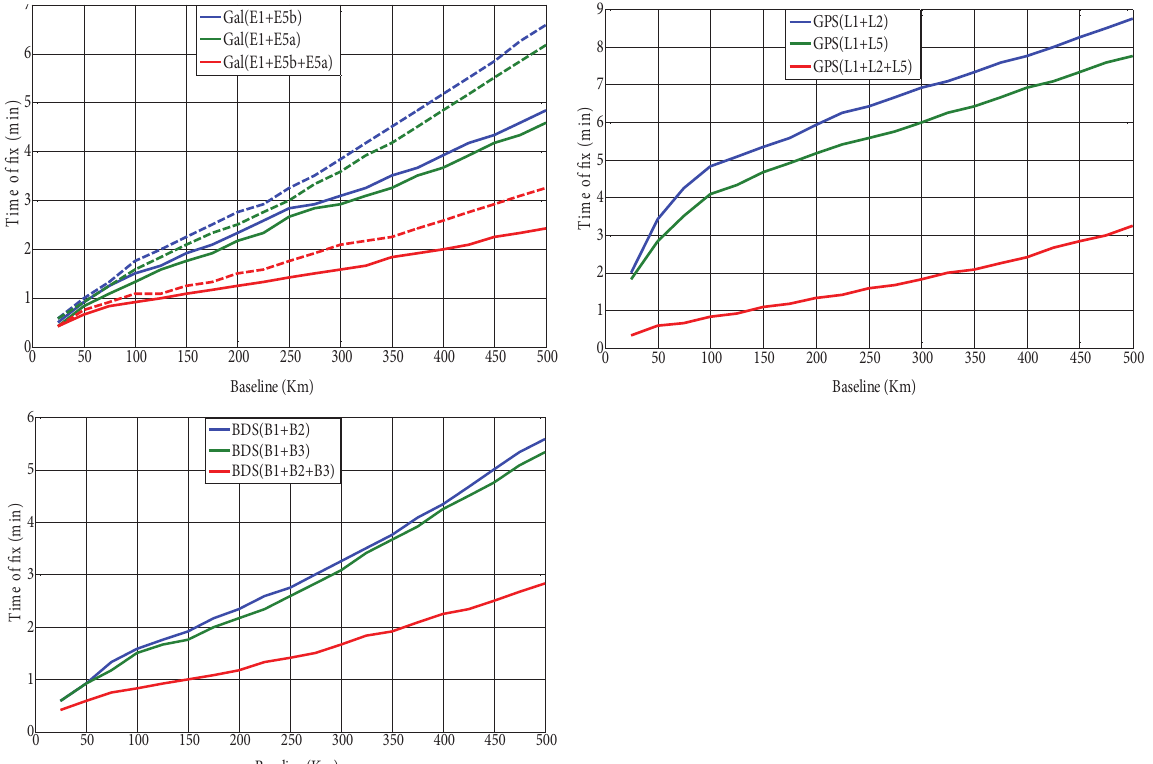
Figure 1. Variation of the time to fix the ambiguities with baseline length for GPS (Top), Galileo (Medium) and BDS (Bottom). Solid line means spatial correlation accounted and dashed line without spatial correlation. 5 s interval, success rate: 99.9% and 10 satellites continuously tracked for each